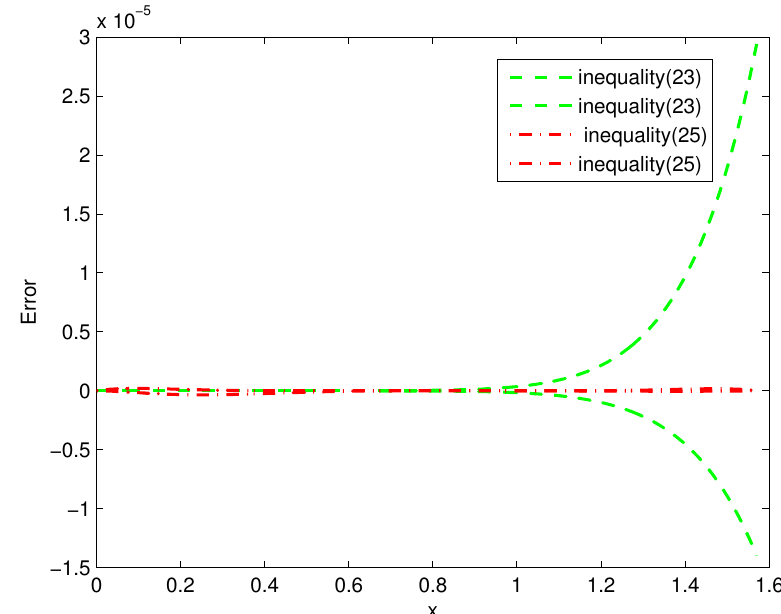
Figure 2. Error plots between cos ( x ) and the bounds of Inequality (23) and Inequality